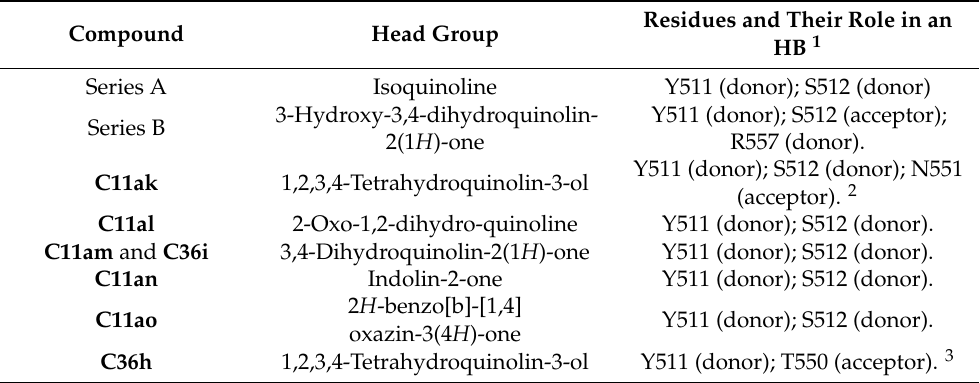
Table 2. Role of the TRPV1 residues in the HB interactions with head groups and an amide of the neck groups of the